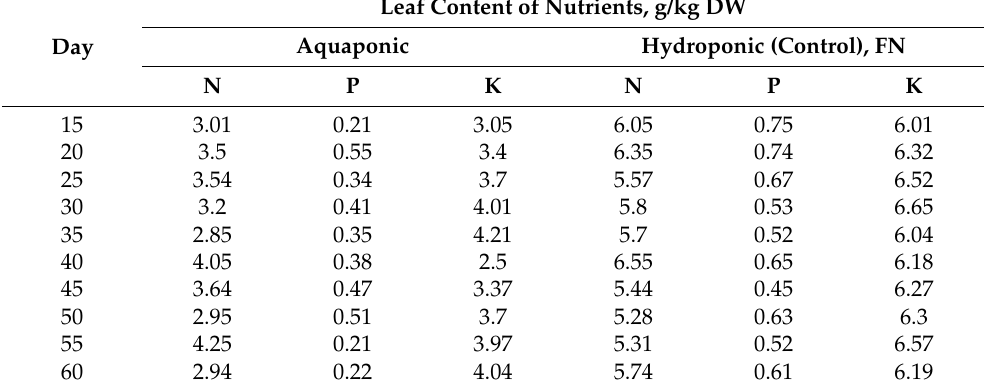
Table 1. Average concentrations of N, P, and K in lettuce for aquaponic and control systems through- out the growth